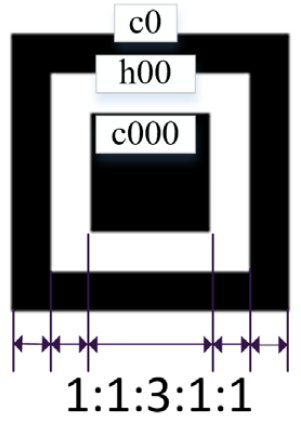
Figure 2. Position detection pattern.